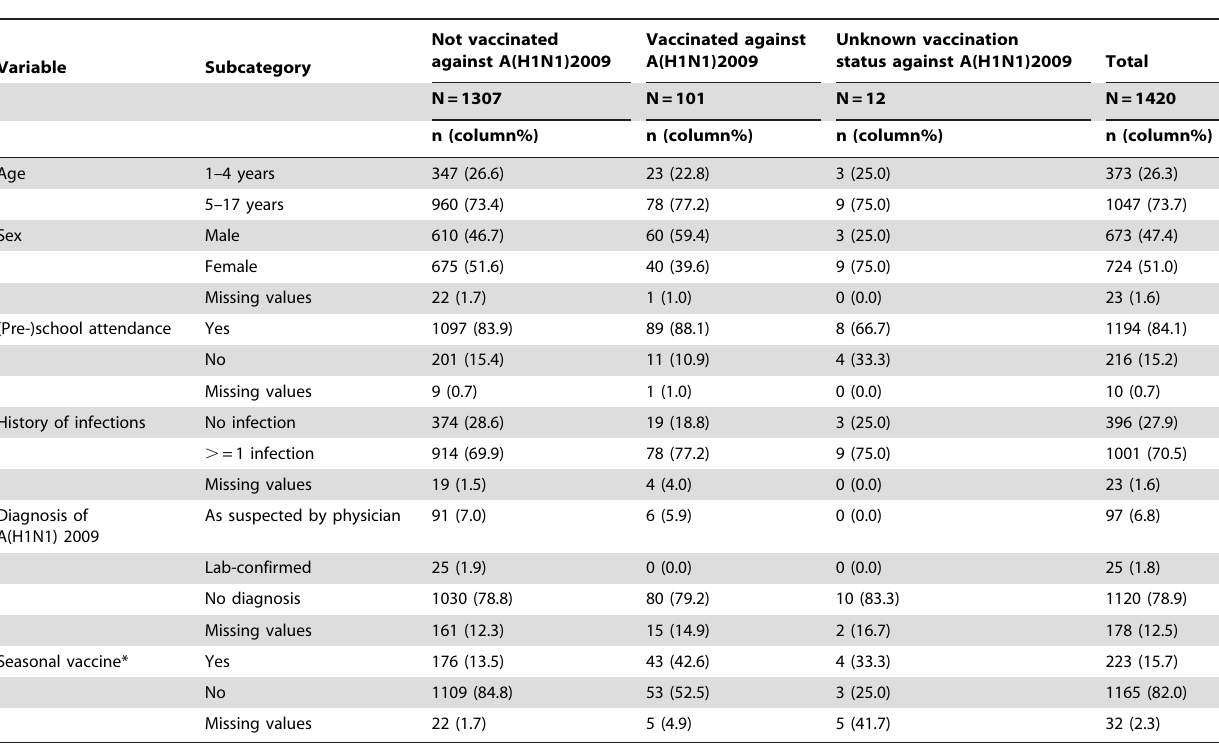
Table 1. Characteristics of the post-pandemic